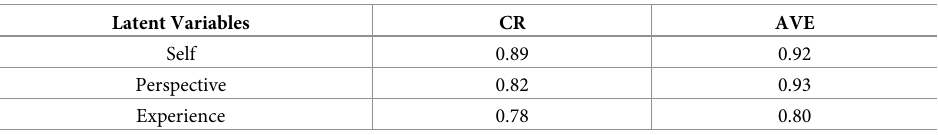
Table 3. CR values and